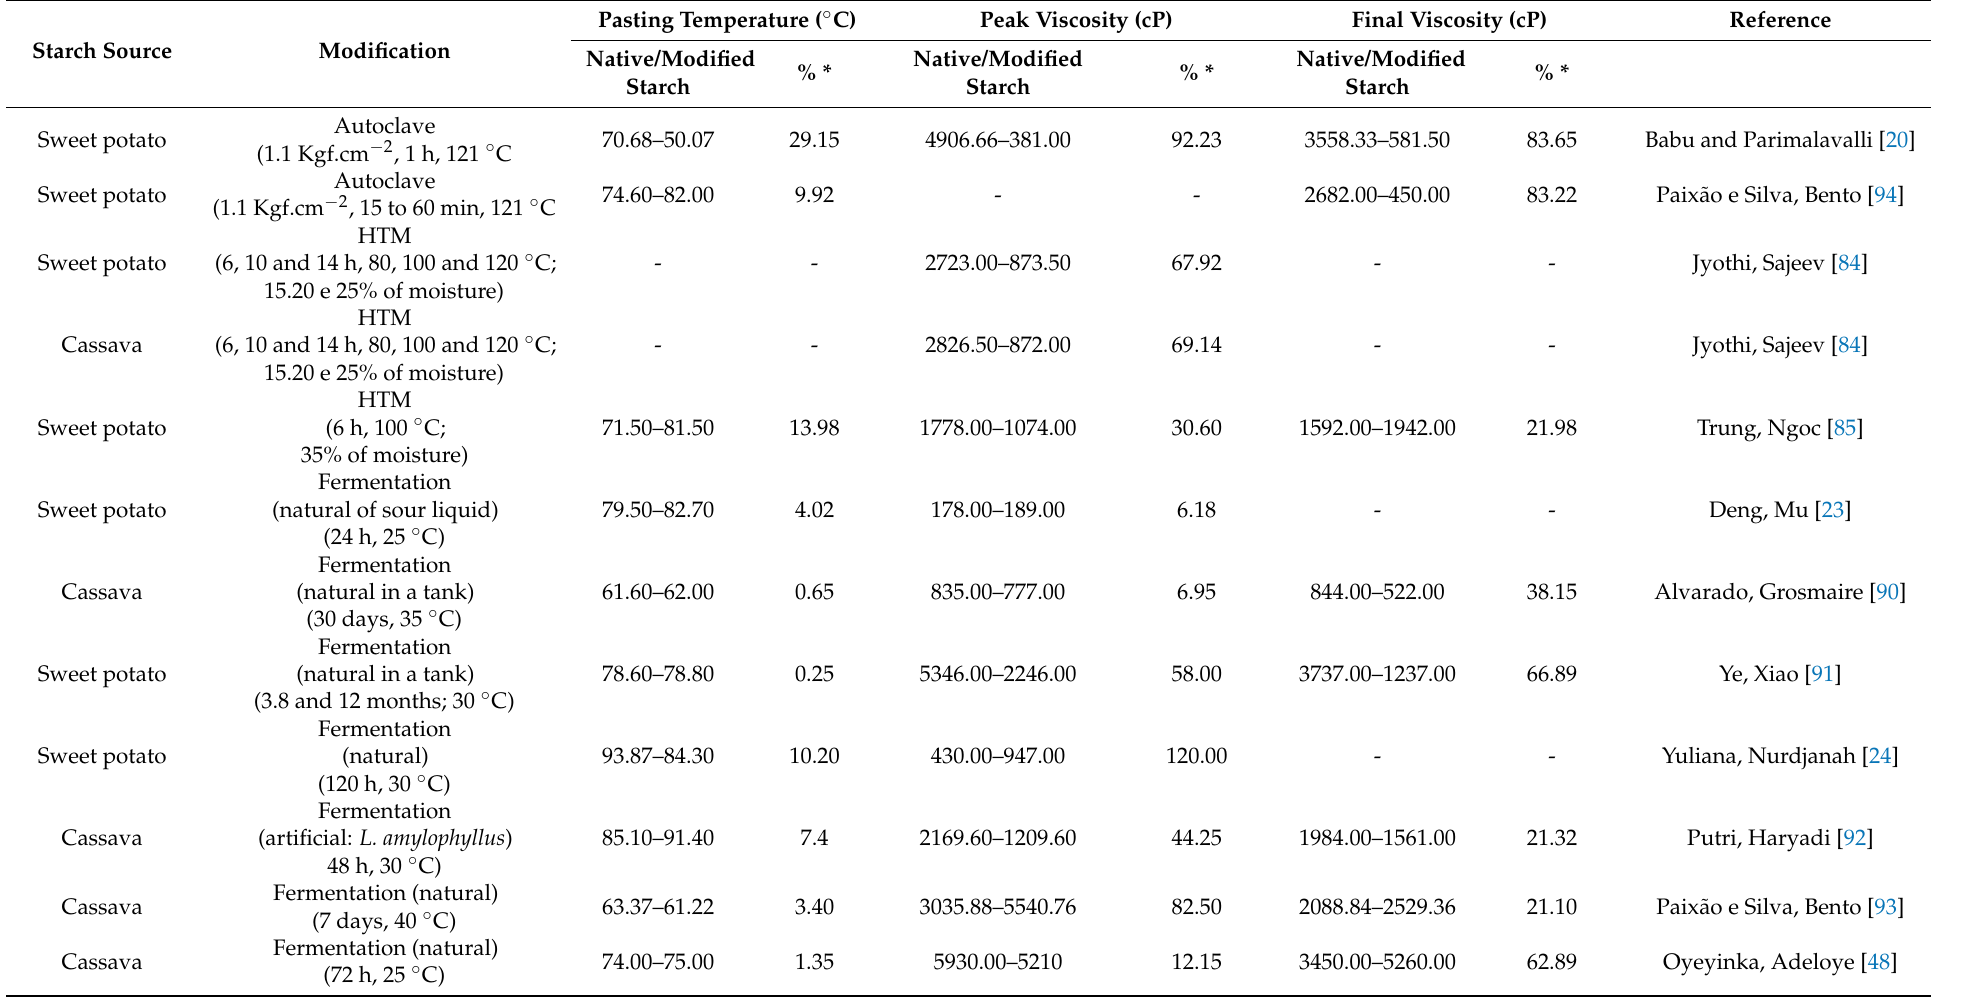
Table 3. RVA parameters (pasting temperature, peak viscosity and final viscosity) of native and modified starches by high hydrostatic pressure (HPP), heat moisture treatment (HTM), autoclave, and